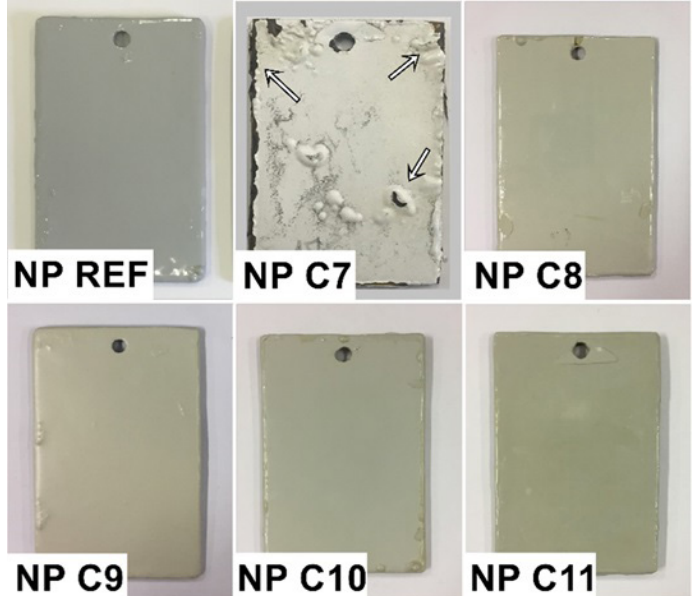
O paint (NP) test specimens after in-situ 2 5